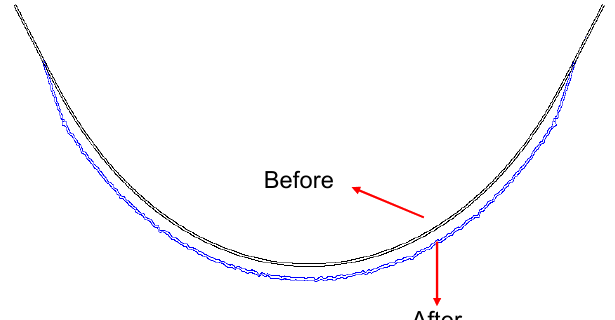
After Figure 11. Comparison of lateral track deformation before and after 50 ◦ C temperature Figure 11. Comparison of lateral track deformation before and after 50 °C temperature increase.